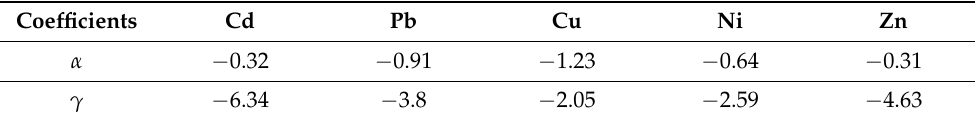
Table 13. Coefficients for the calculation of the critical concentration of free ions as a function of the concentration of free ions with a protective effect (= function of the pH value) according to de Vries et al.